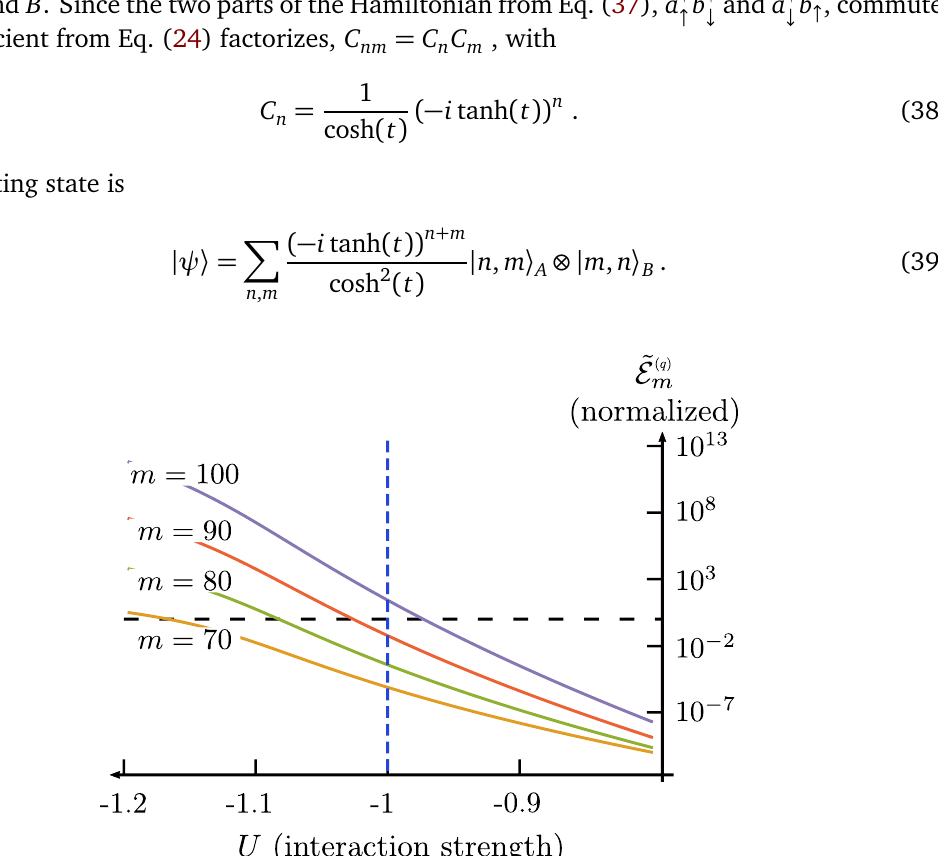
( q ) Figure 2: The Bell correlators ˜ E calculated with the ground state of the Hamilto- m nian from Eq. (33) with N = 100 qubits. The correlators are drawn as a function of the interaction strength U in the vicinity of the critical point U = − 1 (marked with a vertical dashed blue line), for m = 70,80,90 and 100. The correlators are normal- ized to the right-hand side of inequality (18), so that the dashed horizontal line at a ( q ) = 1 marks the local realistic bound for all m constant value ˜ E m